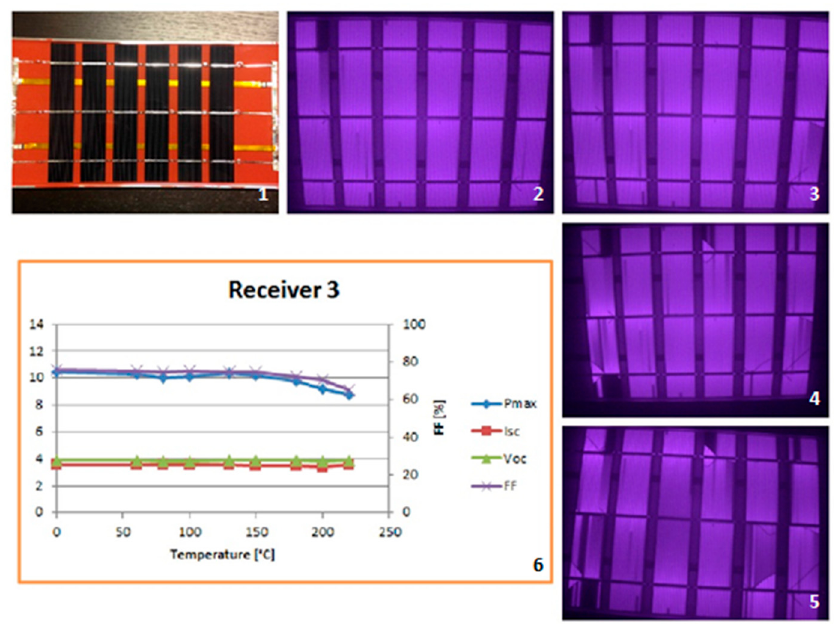
Figure 11. ( 1 ) Receiver 3; ( 2 ) Baseline Round; ( 3 ) Round 5 (150 °C); ( 4 ) Round 6 (180 °C); ( 5 ) Round 8 (220 °C); ( 6 ) Parameters of the IV curve at different temperatures (Isc, Voc and Pmax shown in the left Y axis and FF in the right Y axis).